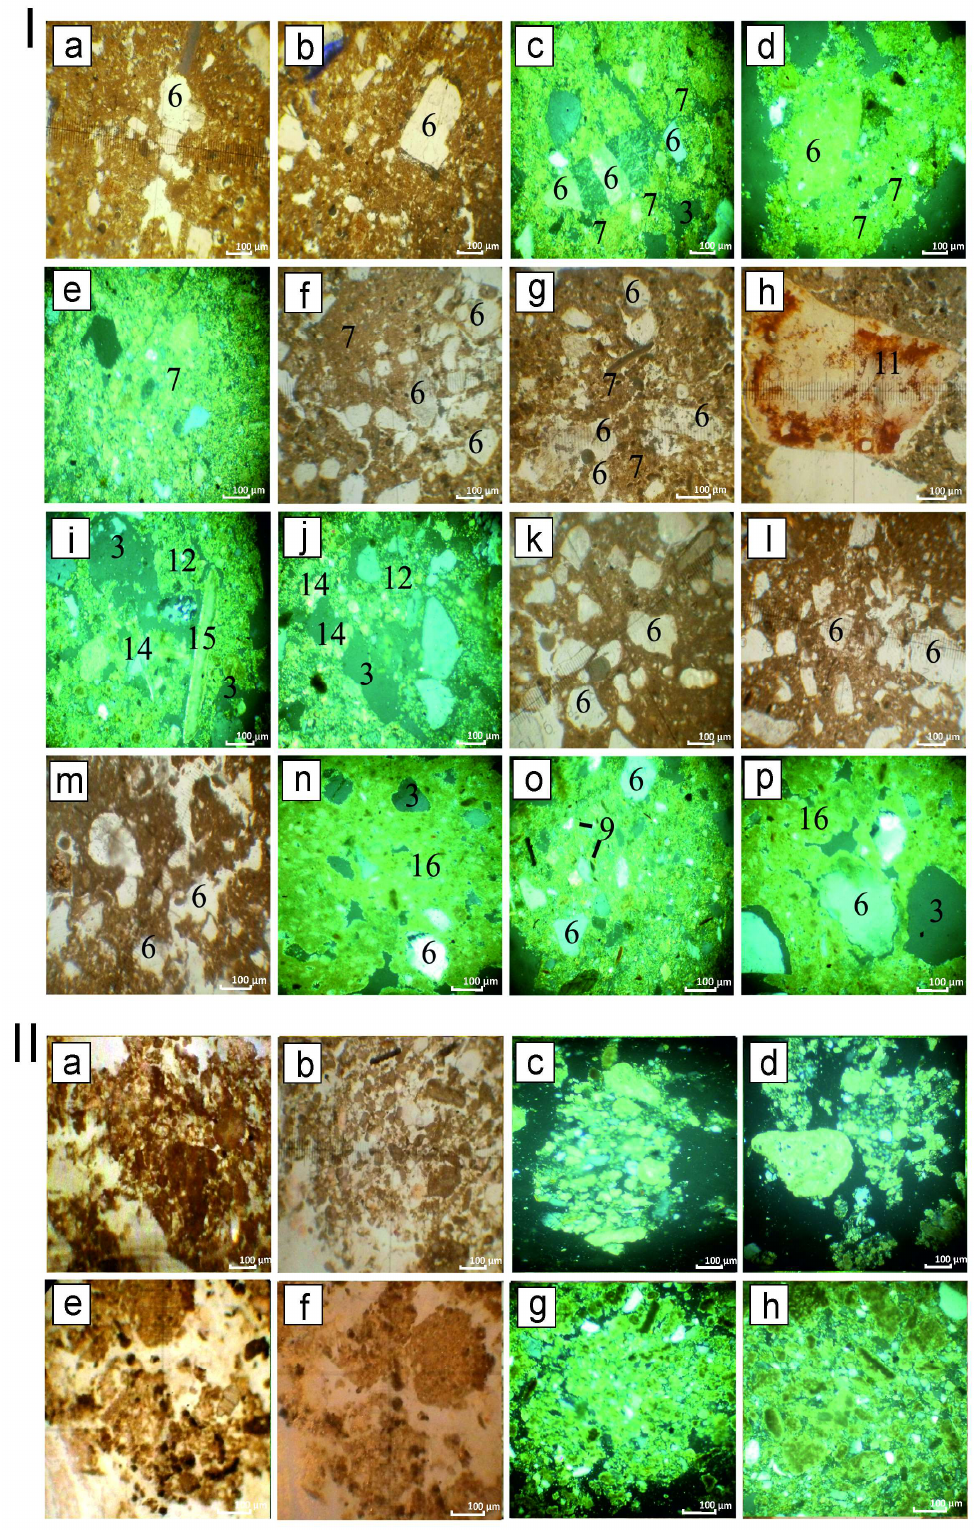
Figure 12. Melnychna Krucha. Micromorphology. I —lower soil of the section 1, ( a , b , f – h , k – m )—PPL; ( c – e , i , j , n – p )—XPL. II —soils of the section 2. Captions: see Supplementary Table S4. Left column: soil horizons’ indices; central column: schematic drawing; right column: photos of the actual soil textures from the respective horizons of the section. ( a , b , e , f )—PPL, ( c , d , g , h )—XPL. Magnification 1:70. Elaboration—ZM.